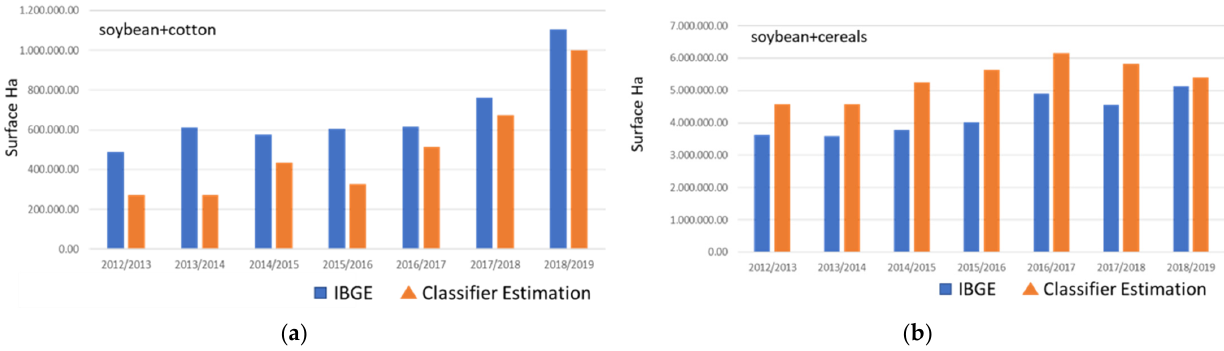
Figure 13. Comparisons between the annual cultivated areas of Mato Grosso given by IBGE-PAM and those obtained by Random Forest classification, for ( a ) cotton (class SCo), and ( b ) cereals (class